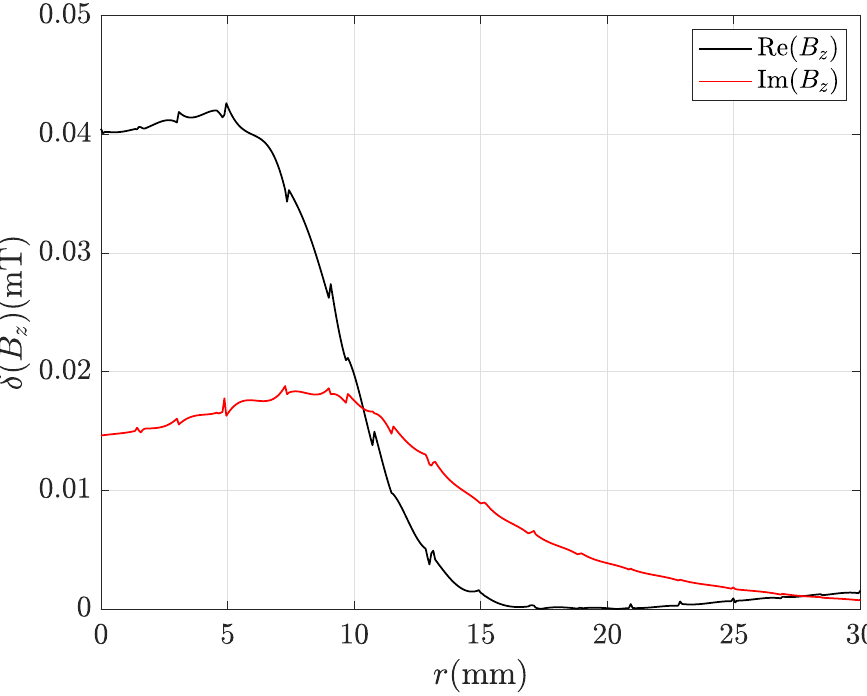
Figure 6. Local discrepancy between CM-BEM and FEM profiles of component B r in Figure 4.